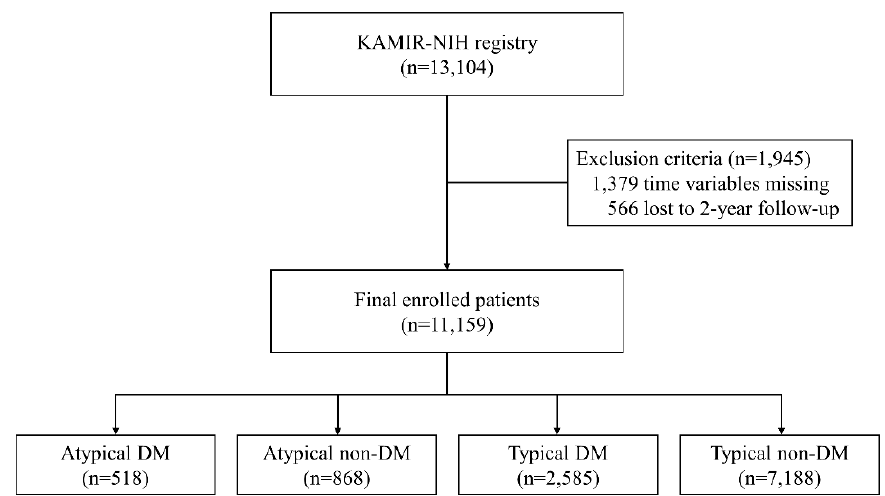
Figure 1. Study flowchart. KAMIR-NIH, Korea Acute Myocardial Infarction-National Institute of Health; DM, diabetes mellitus.